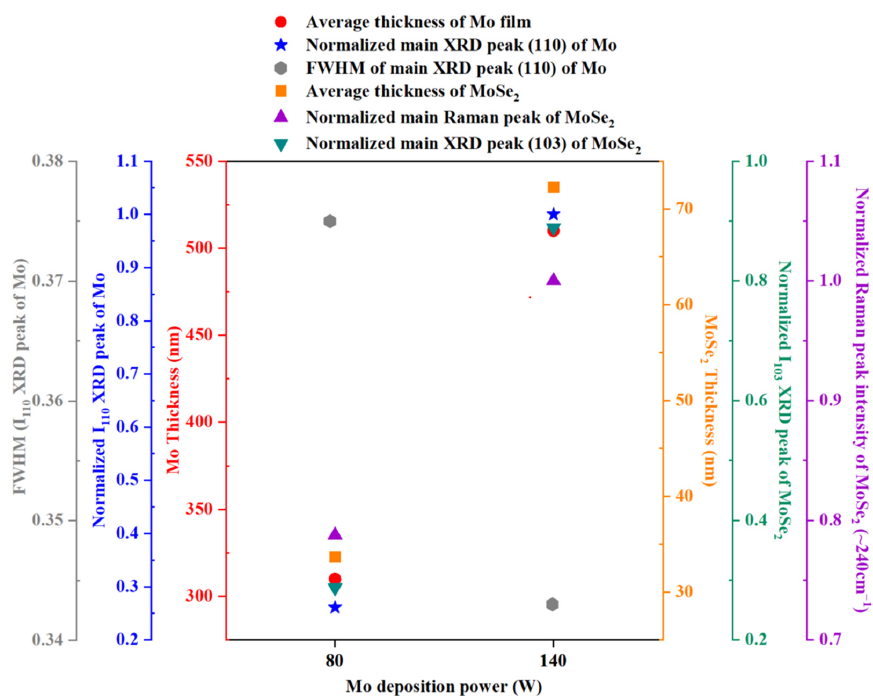
Figure 8. Correlation between A of Mo-80 and Mo-140 samples with B of the corresponding MoSe 2 film. (A: FWHM values and normalized intensity of (110) XRD peak of Mo; thickness of Mo films; B: MoSe 2 film thickness; normalized intensity of main (103) XRD peak of MoSe 2 ; normalized intensity of main Raman peak of MoSe 2 compound).